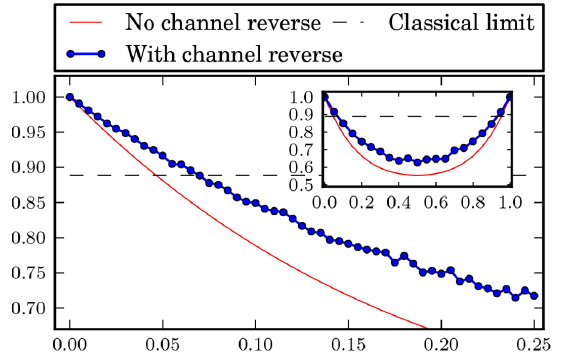
Figure 3. Bit phase flip channel. Probability of winning the pseudo- telepathy game with and without the use of our approach as a function of the noise parameter a for the bit phase flip channel. The inset shows the probability of winning for a M [0; 1].